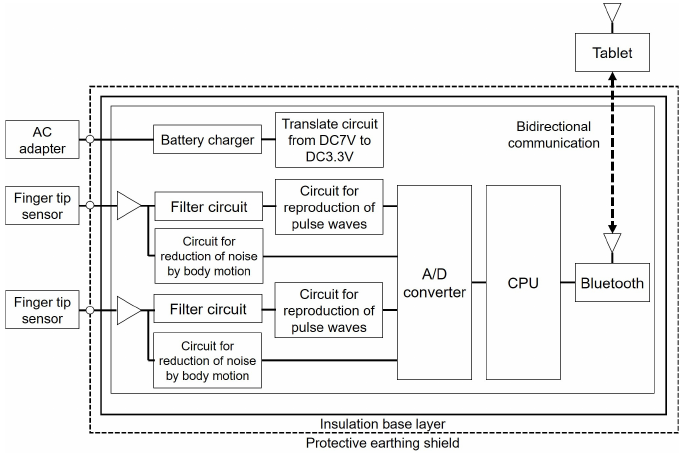
Figure 3. Block chart of the developed